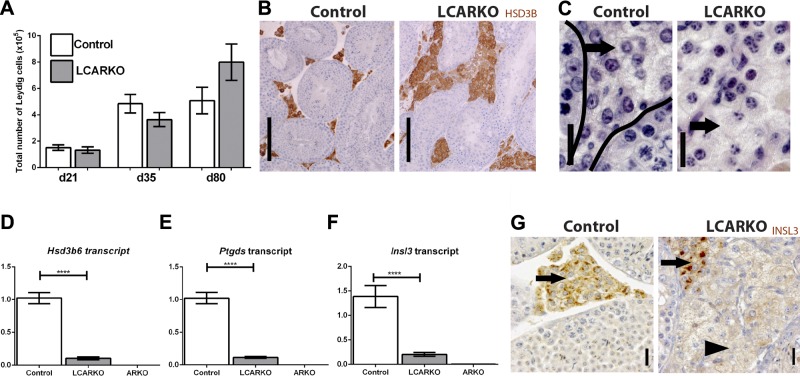
LCARKO Leydig cells reach final adult number but do not express mature Leydig cell markers. A) The total number of Leydig cells per testis is not significantly different between controls and LCARKOs at d 21, 35, and 80. Error bars, sem. B) The percentage of testis occupied by Leydig cells (staining for HSD3B) appears to be larger in the LCARKO than in the control. Scale bars, 100 µm. C) The size of Leydig cell cytoplasm appears larger in LCARKOs than controls at d 80 (lines delineate seminiferous tubules in control panel; arrows indicate interstitium). Scale bars, 20 µm. D) Hsd3b6 is significantly decreased (****P < 0.0001) in LCARKO testis compared to controls at d 80 and is absent in ARKO testis. E) Ptgds is significantly decreased (****P < 0.0001) in LCARKO testis compared to controls at d 80 and is absent in ARKO testis. F) Insl3 is significantly decreased (****P < 0.0001) in LCARKO testis compared to controls at d 80 and is absent in ARKO testis. G) INSL3 staining is widespread throughout the interstitium of control testes, but LCARKO testes show 2 populations of cells with Leydig cell-like morphology: a larger population that does not stain for INSL3 (arrowhead); and a smaller population that does (arrows). Scale bars, 20 µm.